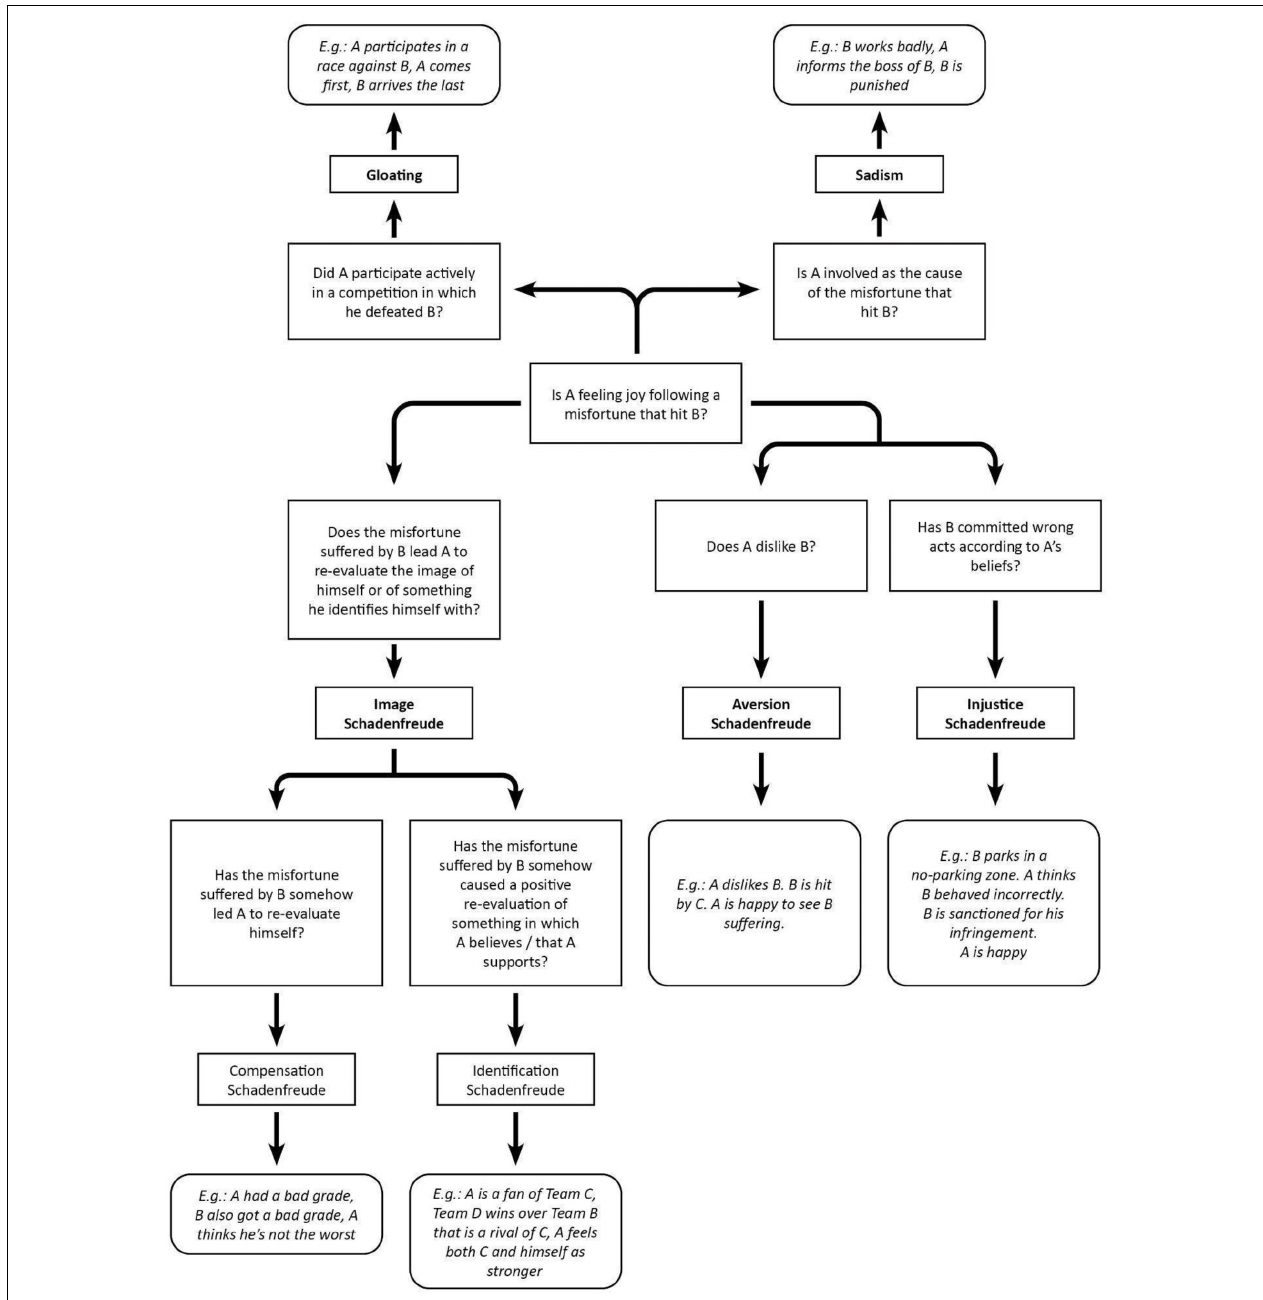
FIGURE 1 | Schadenfreude classification